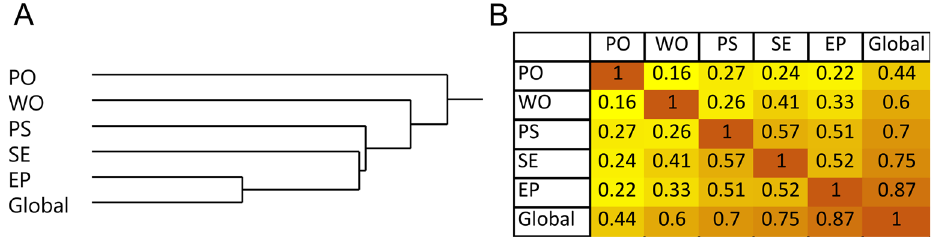
Figure 2. Correlative relationships between cognitive domains. ( A ) Hierarchical clustering of cognitive domains using Ward method. ( B ) Pearson’s correlation matrix. PO perceptual orientation, WO working